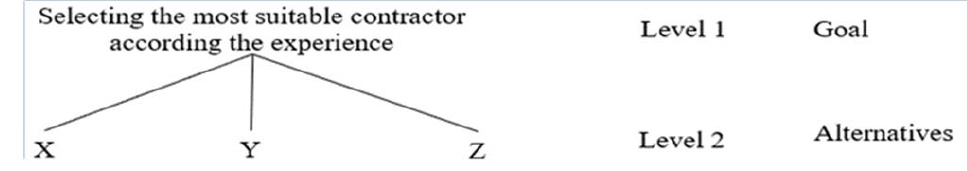
Figure 2. Selection of the Hierarchy Tree.